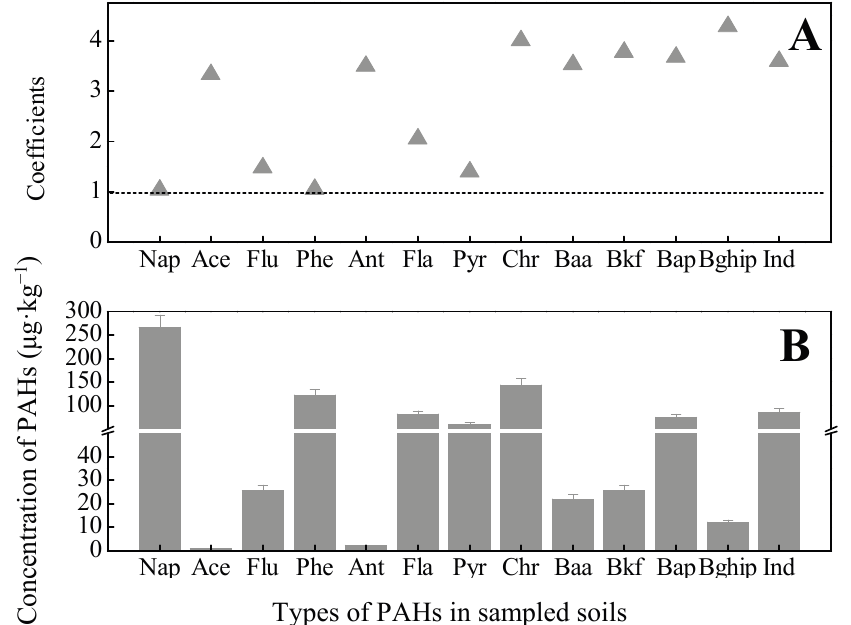
Figure 2. The variable coefficients and mean concentrations (µg·kg − 1 ) of individual